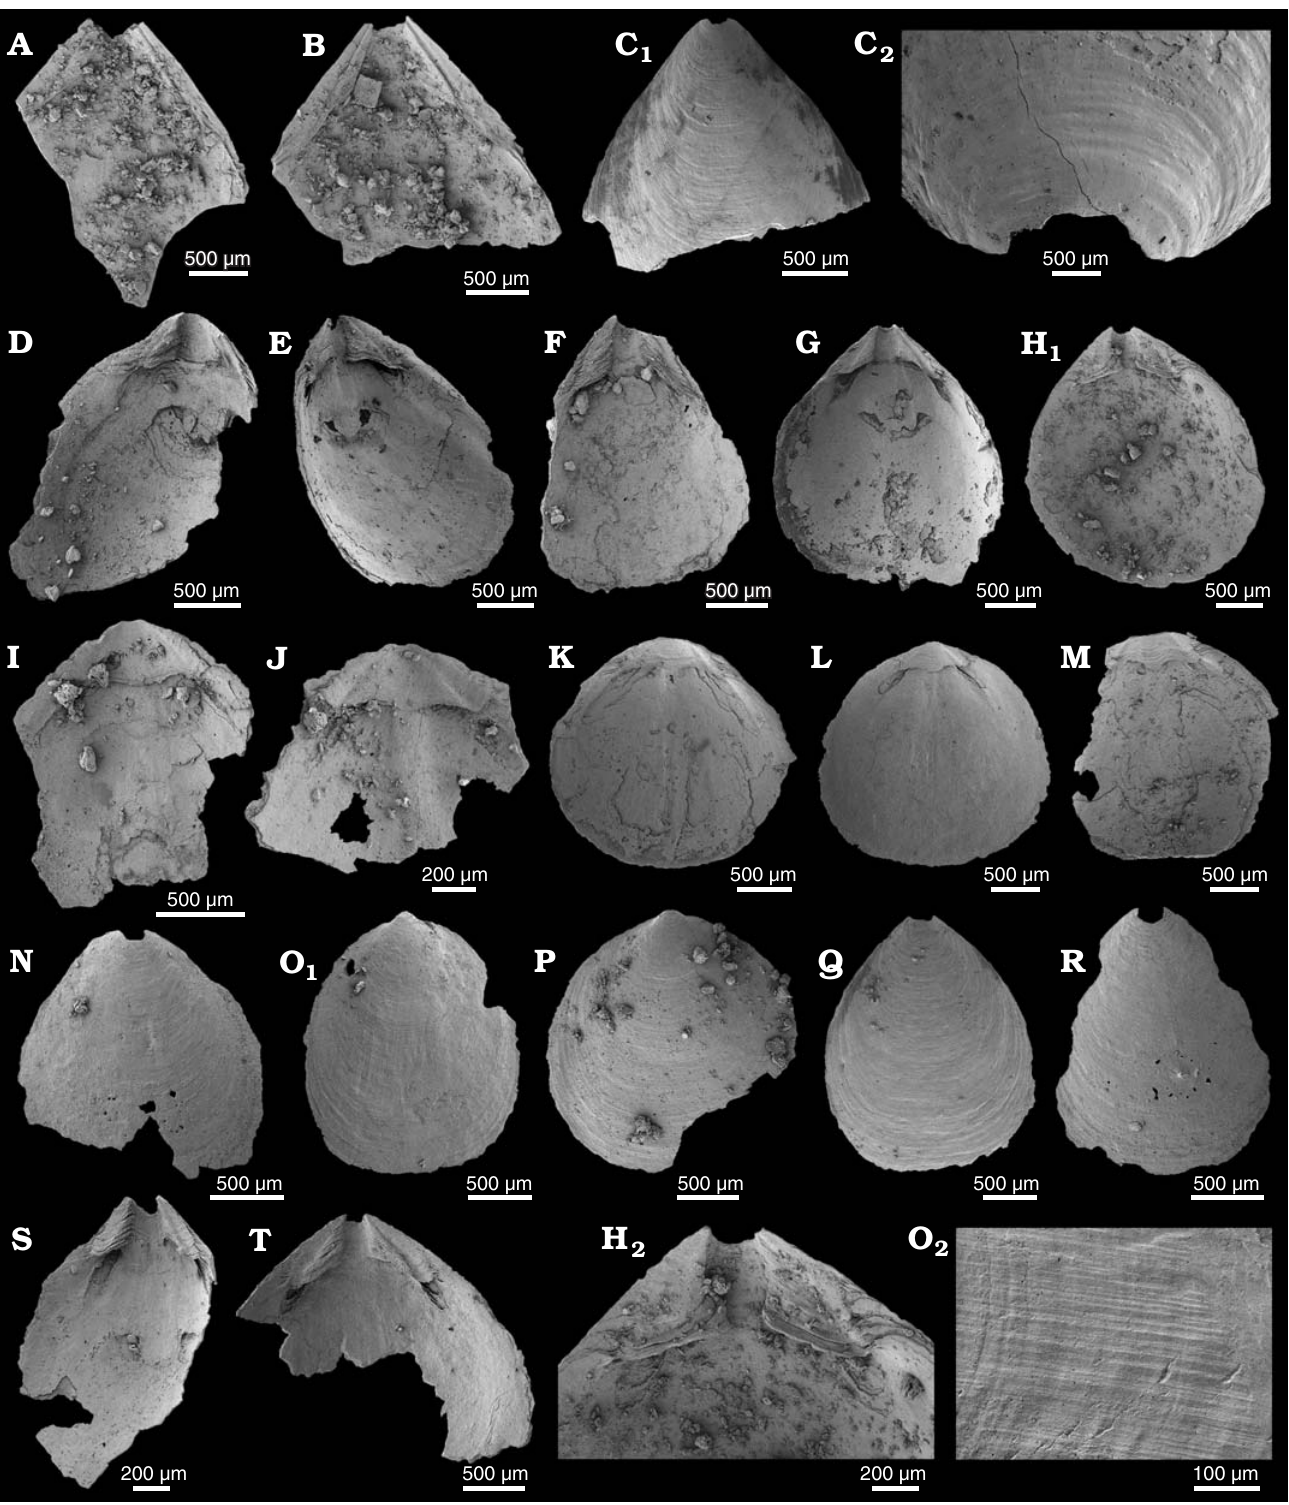
Fig. 7. The lingulid brachiopods Eoobolus sp. (A–C) and Kyrshabaktella davidi Holmer and Ushatinskaya in Gravestock et al., 2001 (D–T) from the lower Cambrian White Point Conglomerate, Kangaroo Island, South Australia. Ventral (A–H, N, Q–T) and dorsal (I–M, O, P) valves. A . SAM P57242 in internal view. B . SAM P57243 in internal view. C . SAM P57244, in external view (C 1 ); C 2 , detail of post larval shell. D . SAM P57245 in internal view. E . SAM P57246 in oblique view. F . SAM P57247 in internal view. G . SAM P57248 in internal view. H . SAM P57249 in internal view (H 1 ); H 2 , detail of the interarea. I . SAM P57250 in internal view. J . SAM P57251 in internal view. K . SAM P57252 in internal view. L . SAM P57253 in internal view. M . SAM P57254 in internal view. N . SAM P57255 in external view. O . SAM P57256 in external view (O 1 ); O 2 , detail of external radial and concentric ornament. P . SAM P57257 in external view. Q . SAM P57258 in external view. R . SAM P57259 in external view. S . SAM P57260 in internal view. T . SAM P57261 in internal